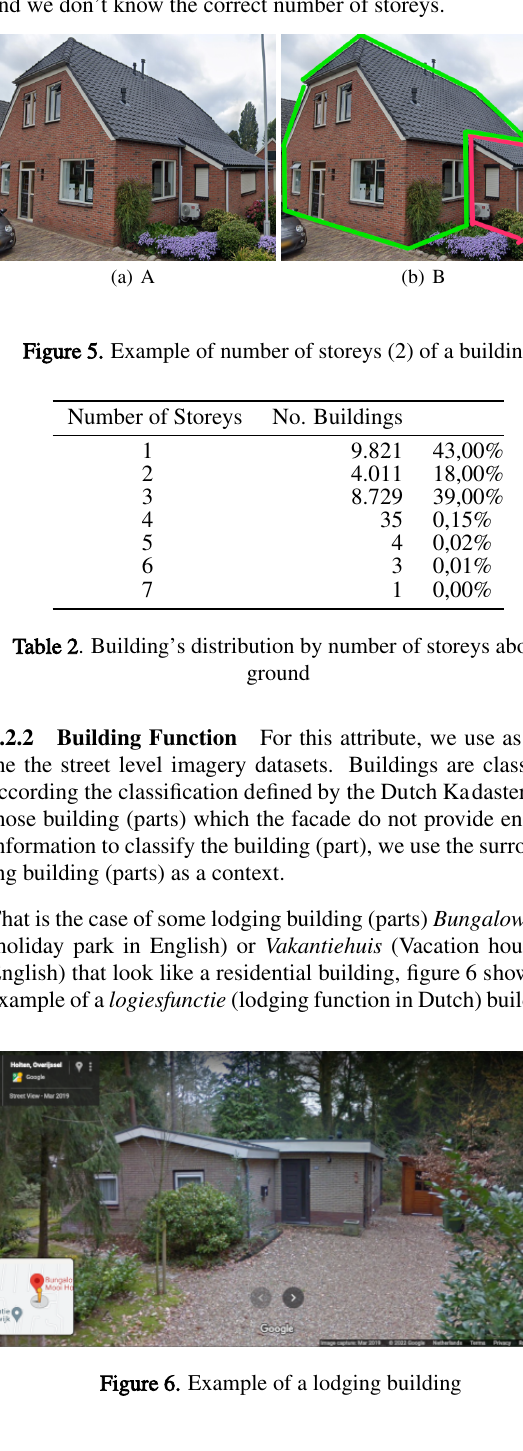
Table 3. Building’s distribution by class